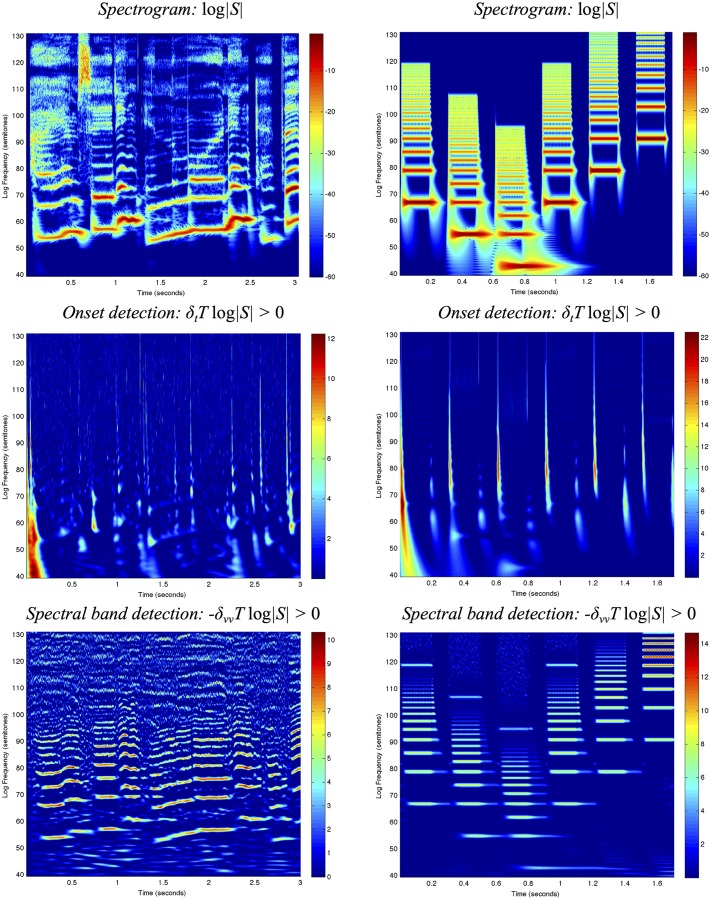

Second layer receptive field responses obtained by applying spectro-temporal scale-space derivatives to the logarithmic spectrogram of (left column) the first 3 seconds of “Tom’s diner” by Suzanne Vega with the lyrics “I am sitting in the morning at the …” or (right column) a synthetic signal containing of harmonic spectra with 20 partial tones and a spectral slope of 6 dB/octave at different fundamental frequencies: (top row) Original spectrogram.(middle row) Onset detection from the positive part of the first-order temporal derivatives ∂t
 log ∣S∣ > 0 using a cascade of four time-recursive filters with temporal scale proportional to the temporal window scale σt=τ=0.75σw and with logspectral smoothing scale σ
ν = 0.5 semitones. (bottom row) Spectral band detection from the negative part of the second-order temporal derivatives ∂νν
 log ∣S∣ < 0. The vertical axis shows the logarithmic frequency expressed in semitones with 69 corresponding to the tone A4 (440 Hz).